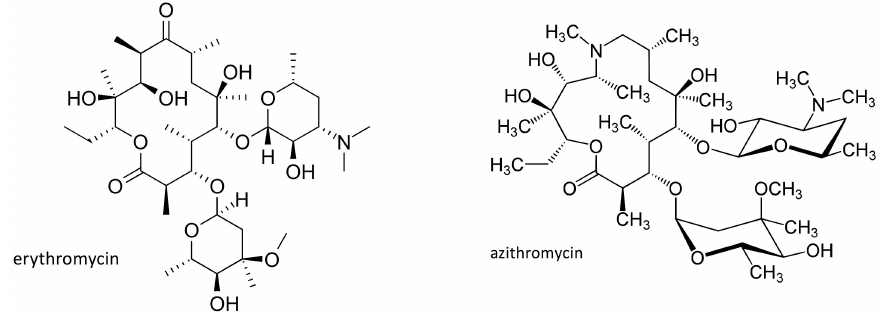
Figure 5. Chemical structures of erythromycin and